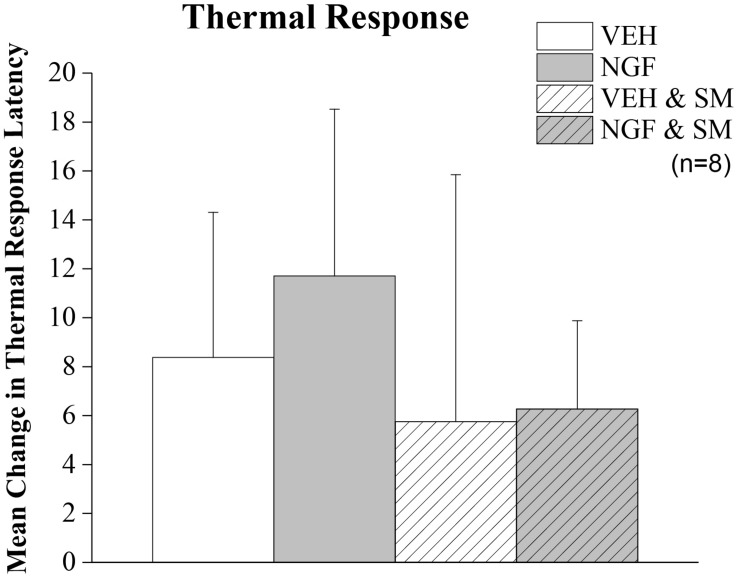
Thermal allodynia. Mean change in thermal hindpaw response latency to 50°C stimulus. Rats were tested on Day –1 and Day 9. Trunk injection of NGF did not significantly alter distant noxious hindpaw thermal response latencies. Statistical analyses were performed by ANOVA and data reported as mean ± SD.